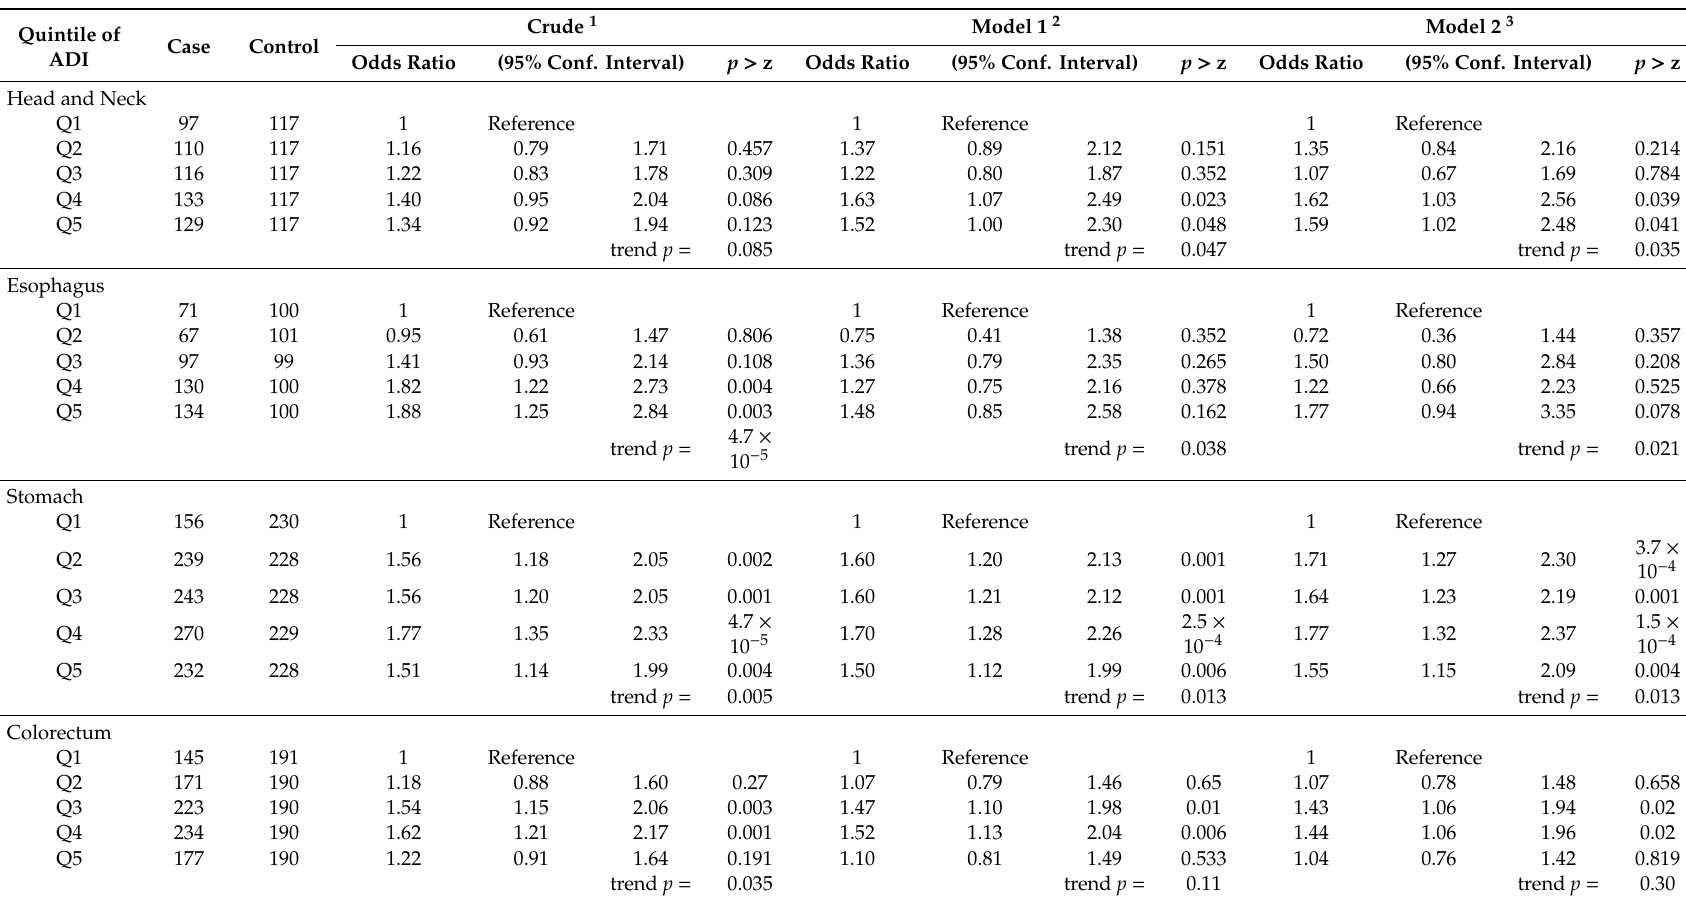
Table 3. Association between quintiles of the deprivation index and risk of subject cancers by sites 4